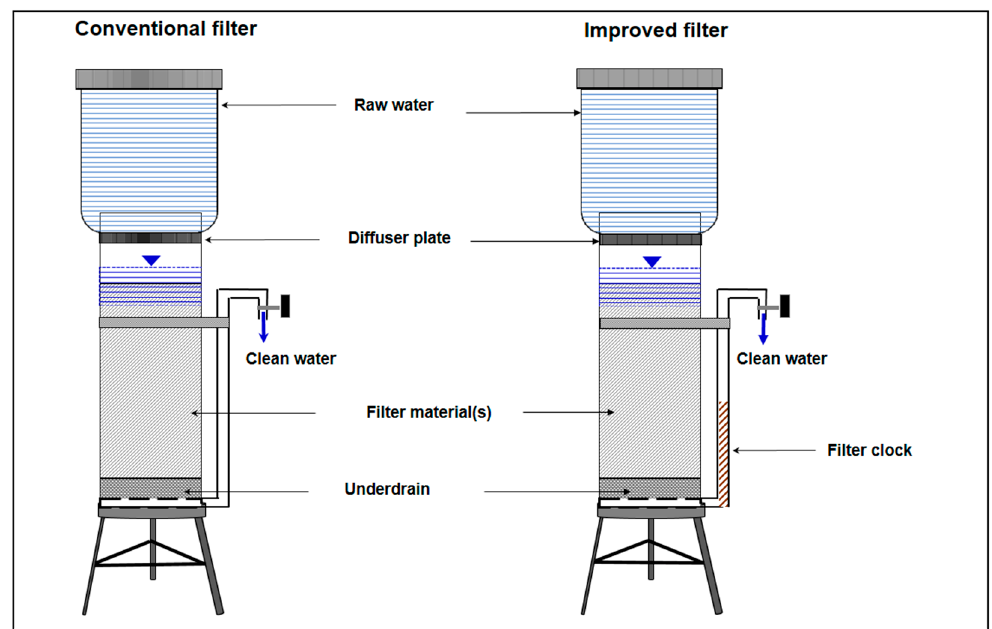
Figure 1. Basic concept of a filter-clock subsequent to a conventional filter. The Fe 0 -based filter-clock clogs promptly after the exhaustion of the capacity of the conventional filter (at t ∞ ). This operating principle corresponds to the one of colored indicators widely used in Analytical Chemistry (titration reaction).